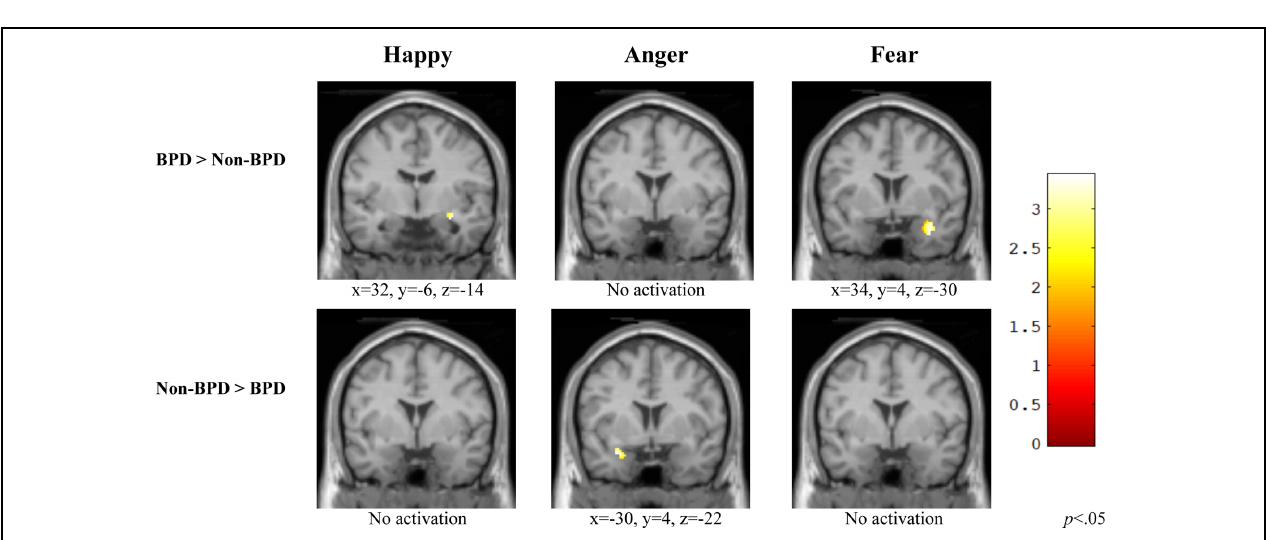
FIGURE 3 | Group comparisons of Cingulate Cortex ROI activity in three affective categories. Across affective types, individuals diagnosed with BPD demonstrated a different pattern of activation than those without BPD, and exhibited greater midline cingulate activity within the ROI than those with no diagnosis. BPD, borderline personality disorder; Non-BPD, No diagnosis.